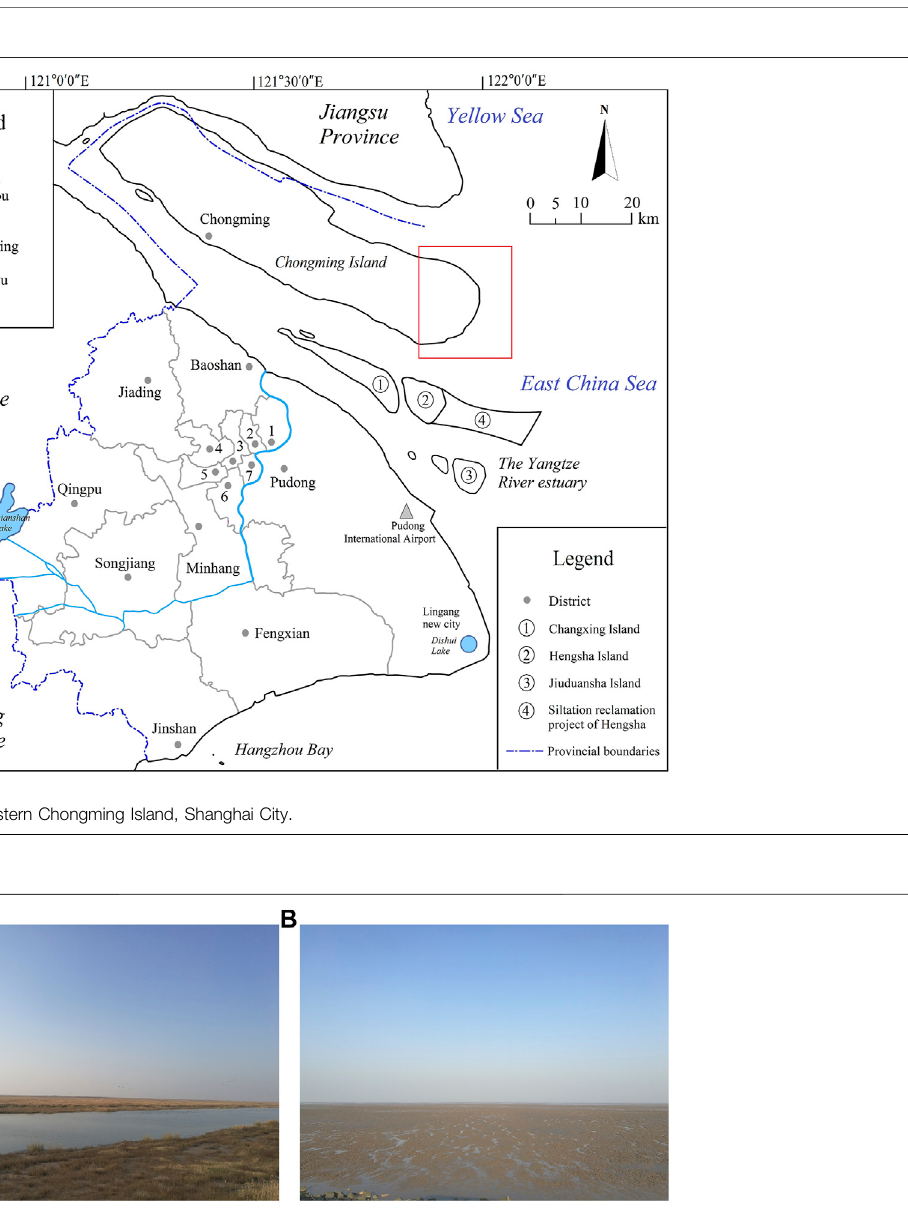
Frontiers in Environmental Science |